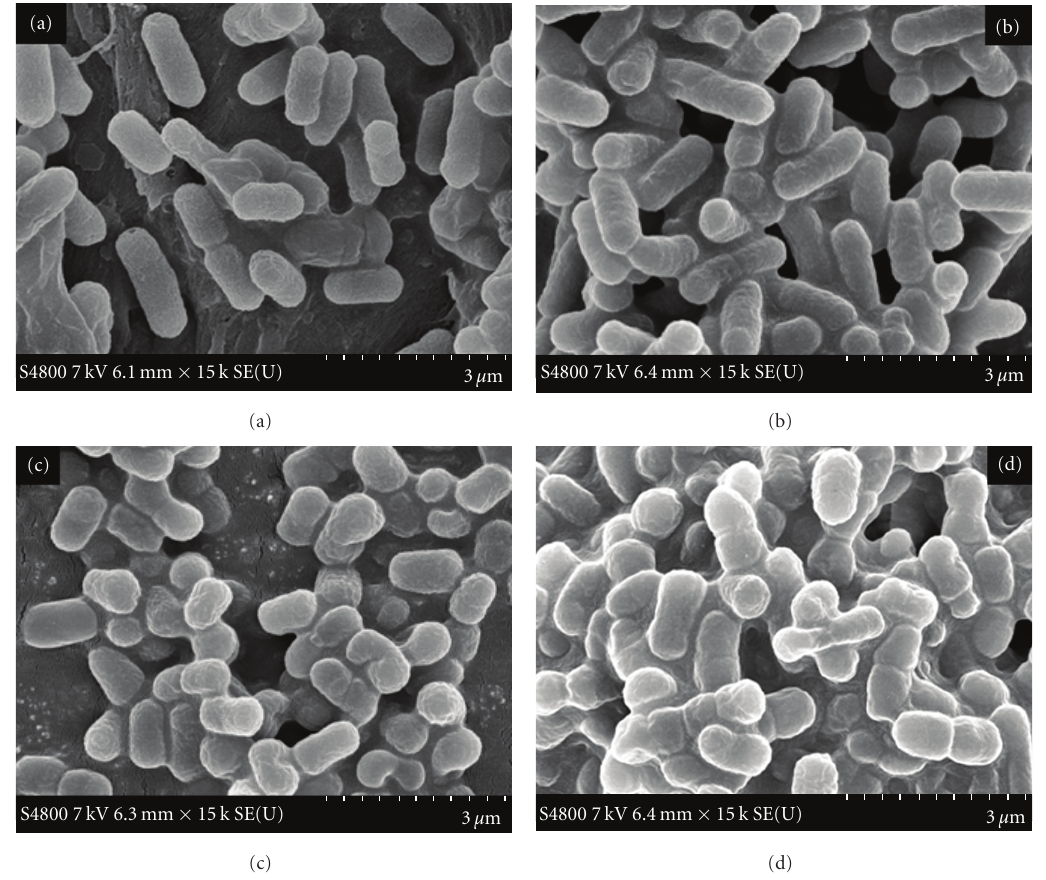
Figure 2: E ff ect of lactic acid and copper on the morphology of E. coli O157:H7 as demonstrated by scanning electron microscopy: